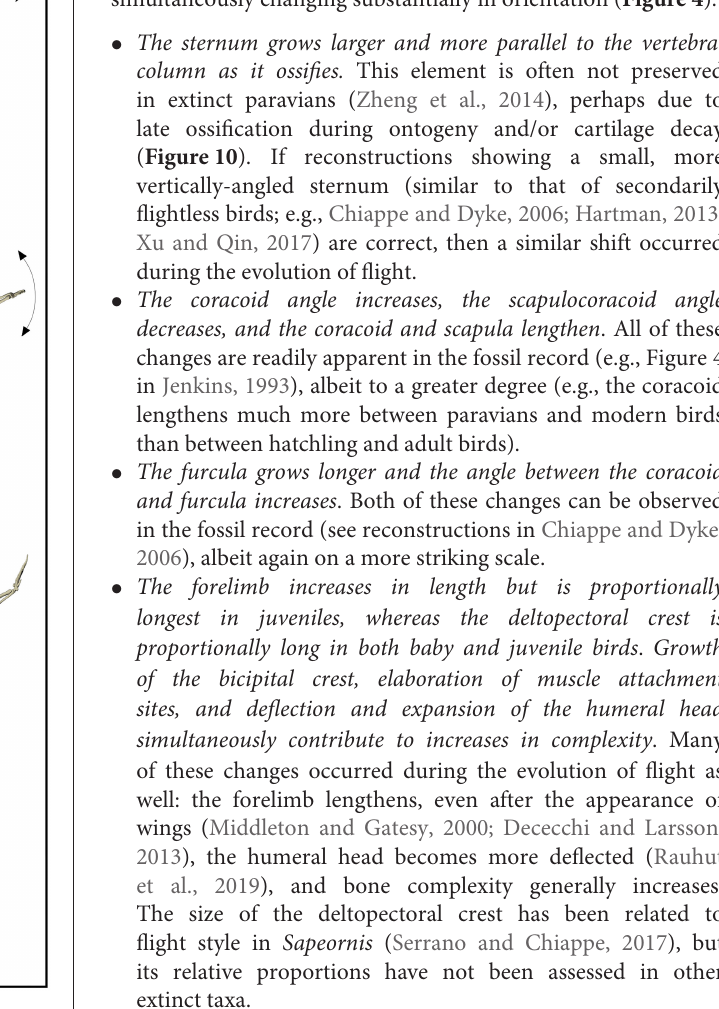
FIGURE 7 | Muscle leverage (moment arm length). When standardized by notarium length, moment arm lengths generally increase through ontogeny but show different developmental patterns, depending on the direction of motion. Muscle leverage for elevation/depression (z axis) and protraction/retraction (y axis) tends to peak in juveniles, most likely due to their proportionally long forelimbs and deltopectoral crests ( Figures 2 , 3B ). In contrast, moment arms for long axis rotation (x axis) tend to peak in adults, whose exaggerated muscle attachment sites help pull muscles away from the long axis of the humerus ( Figures 2 , 5 ). Each line represents the relative moment arm length (leverage) for one shoulder muscle about the z, y, or x axis, during maximal effort wing-assisted incline running (WAIR) in chukars. Figure modified from Heers et al.